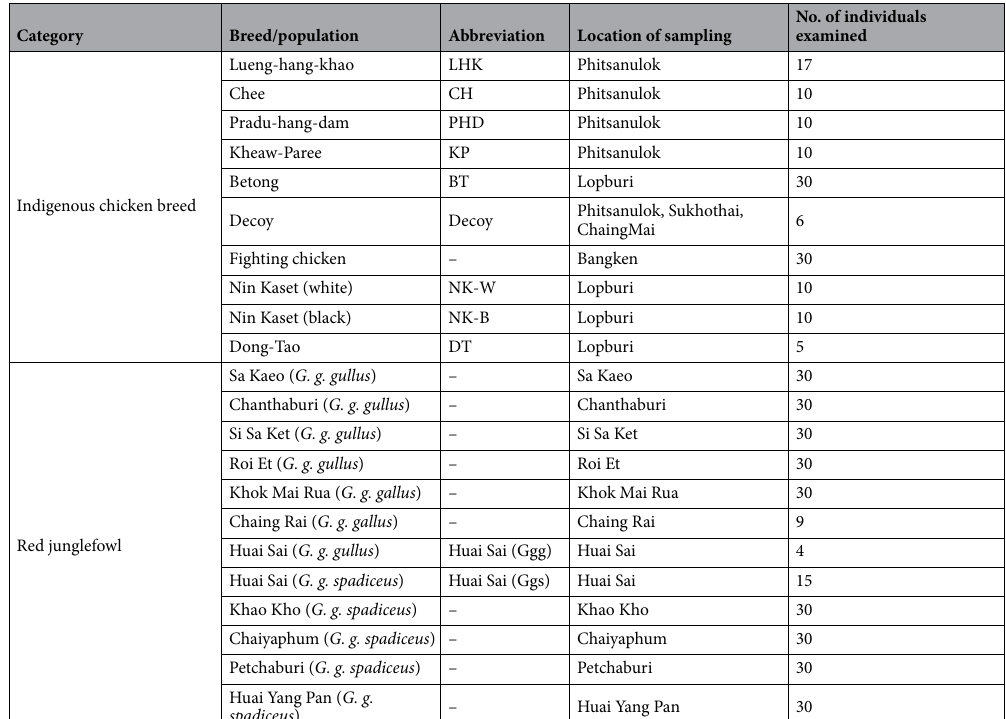
Table 1. List of indigenous chicken breeds and red junglefowl populations examined in the present study.